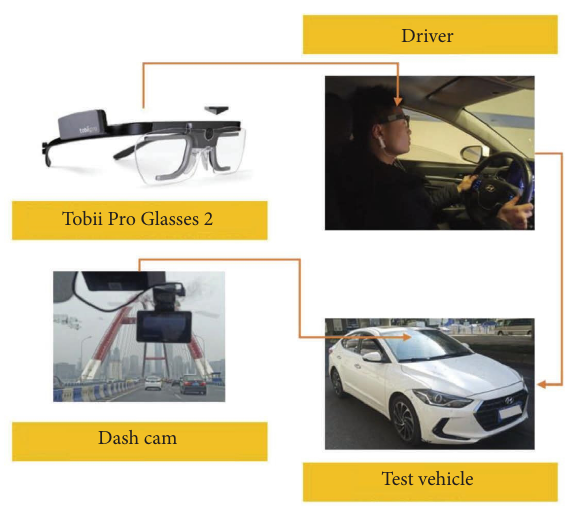
Figure 1: Test equipment and installation